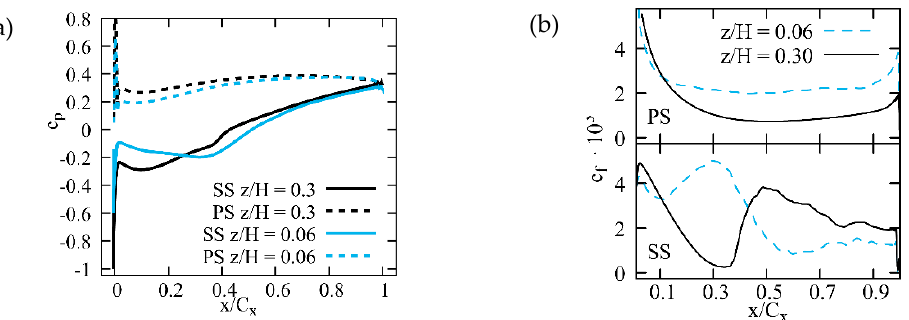
Figure 12. Pressure ( a ) and friction ( b ) coefficients on the blade at two different spanwise positions, near the blade tip ( z/H = 0.06 ) and at midspan ( z/H = 0.3 ). Now turning to the blade midspan ( z/H = 0.3 ), the shape factor is much larger near the leading edge peaking around x/C x ≈ 0.35 then dropping to values around 1.5. Hence, the boundary layer initially is laminar and undergoes transition to a turbulent boundary layer around at this position, which is also reflected by a minimum of the friction factor at this axial position (Figure 12b). The difference in fluctuation levels at the LE between midspan and tip region is directly related to the higher fluctuations within the incoming boundary layer. At the TE very similar profiles are observed for both spanwise positions, indicating a small influence of the TLV on the TE part of the blade. This is also observed in the pressure distribution (Figure 12a), c p values at the TE for both spanwise positions are similar.